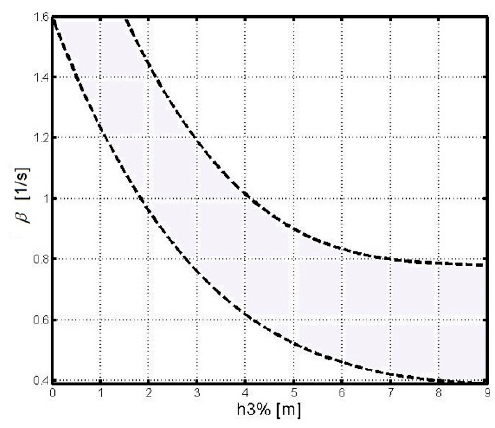
Figure 1. Boundary relation between the parameter beta and wave height.